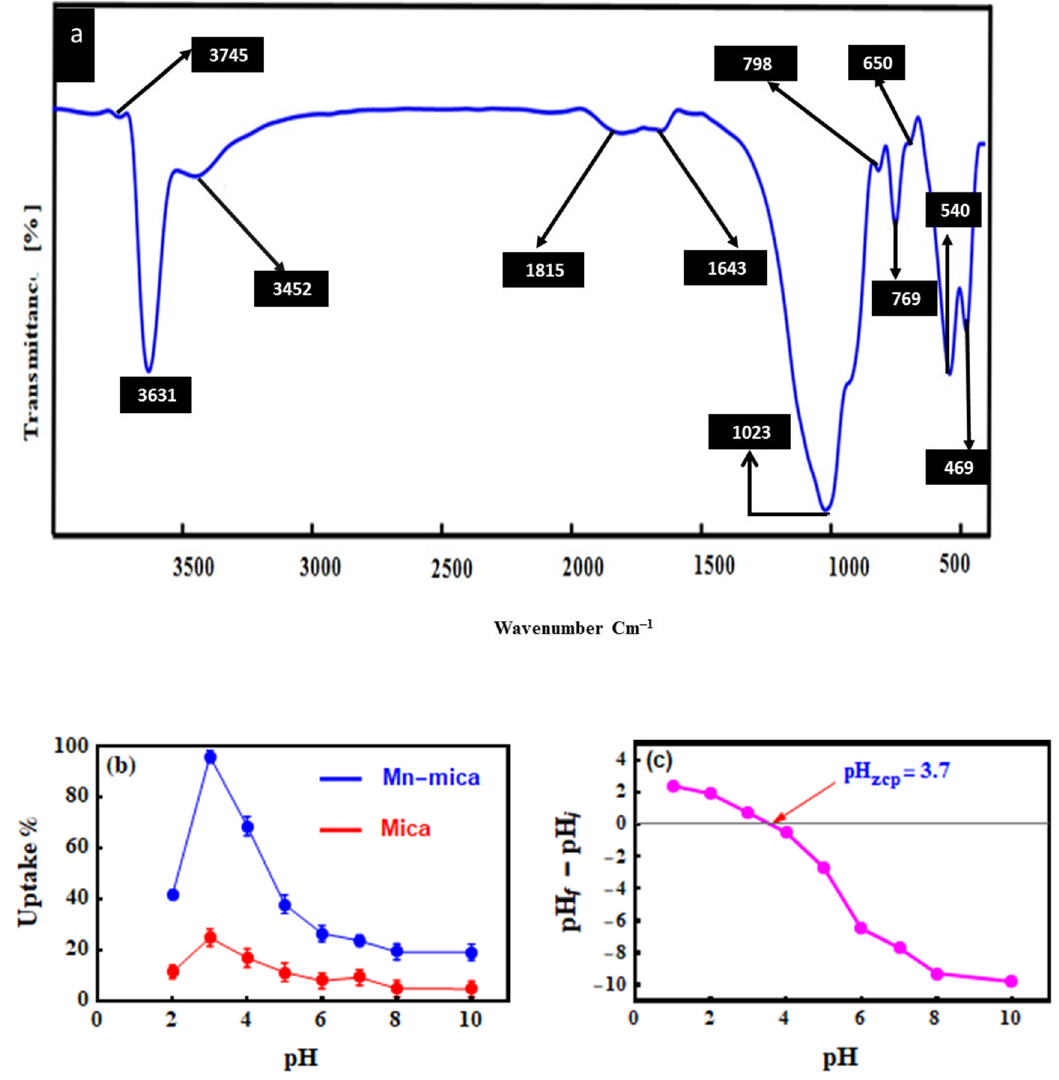
Figure 2. Infrared spectrum of the well crystallized mica showing the main absorption bands ( a ), effect of pH on the uptake of MO by the well-crystallized Mn–mica ( b ) and zero charge point of Mn–mica ( c ).